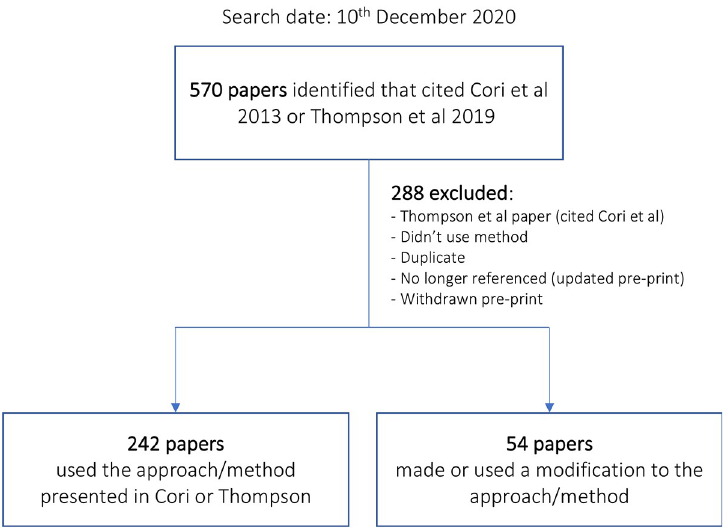
Fig 2. Schematic to illustrate the scoping review process. Note: fifteen papers are counted as both unmodified and modified (i.e., EpiEstim was used as a baseline to compare a modified approach to).